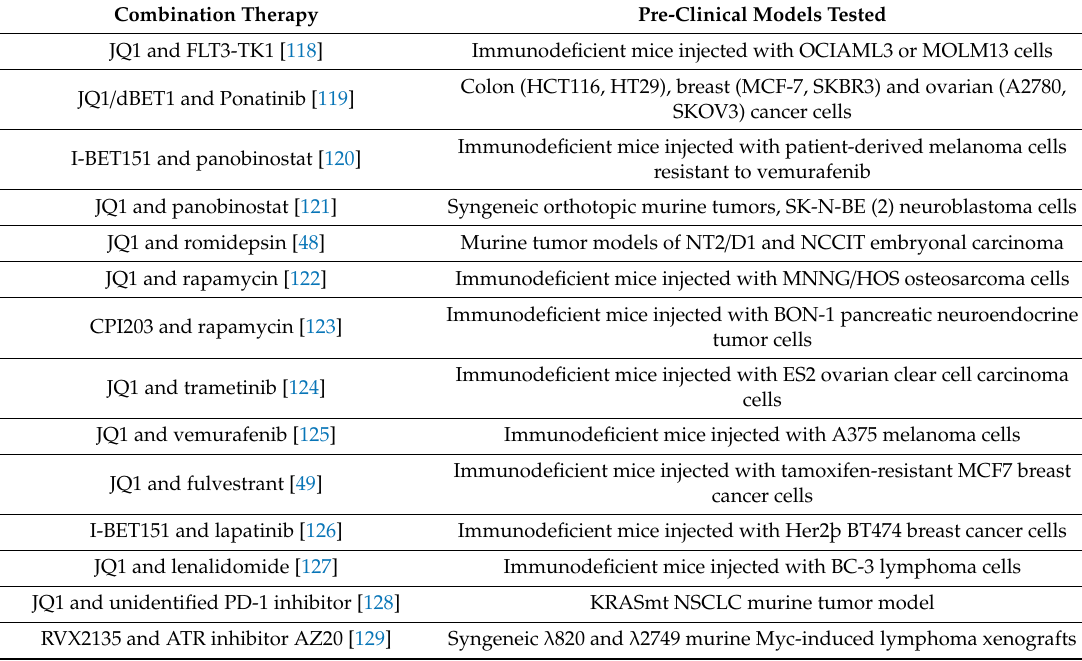
Table 3. Various combinations used with BET inhibitors on pre-clinical